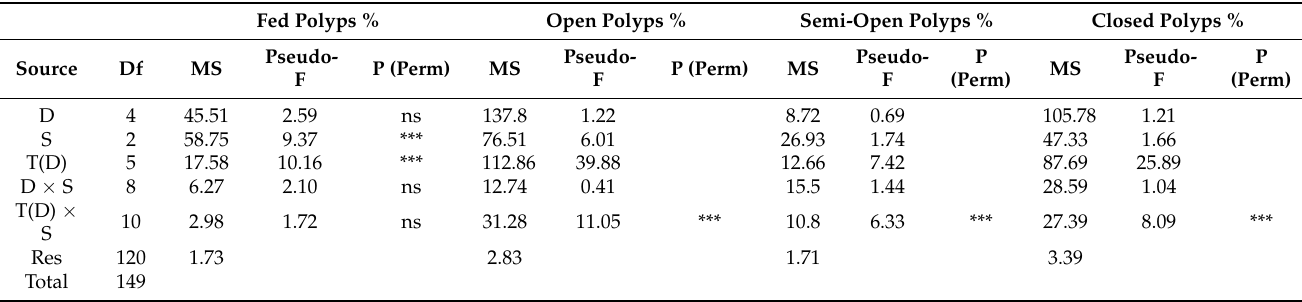
Table 2. Results of permutational analyses (PERMANOVA) on the percentages of fed, open, semi-open, closed polyps in the species investigated across several temporal scales (Day, Time).